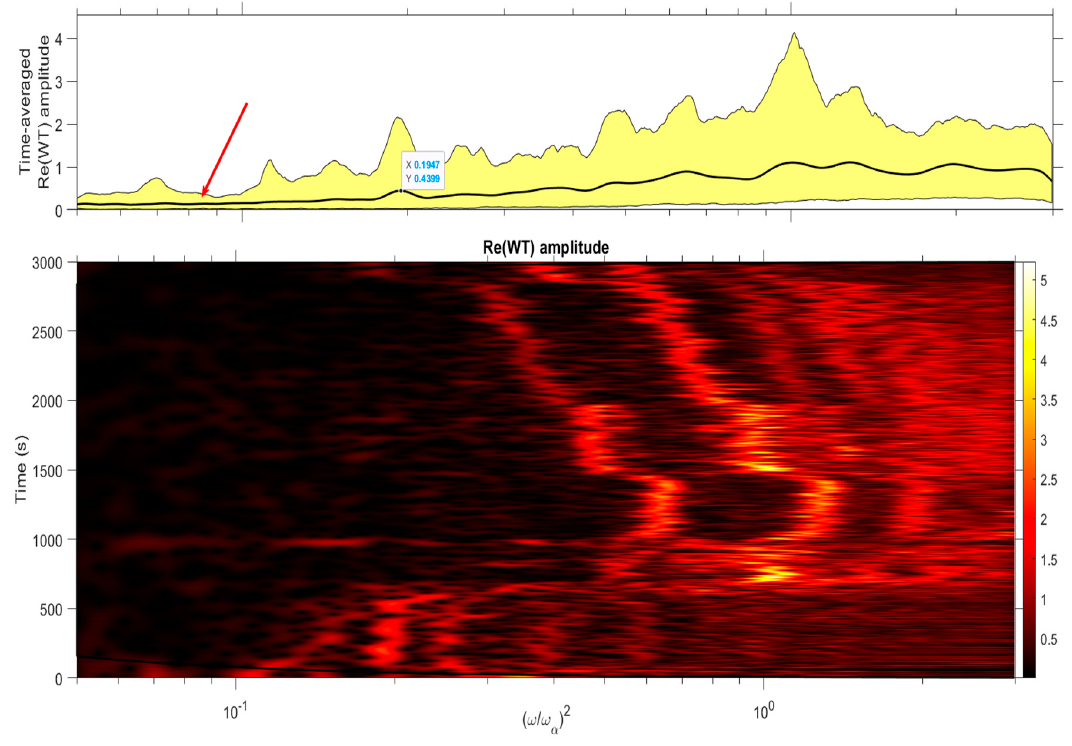
(cid:104) (cid:105) . α t ) cos (